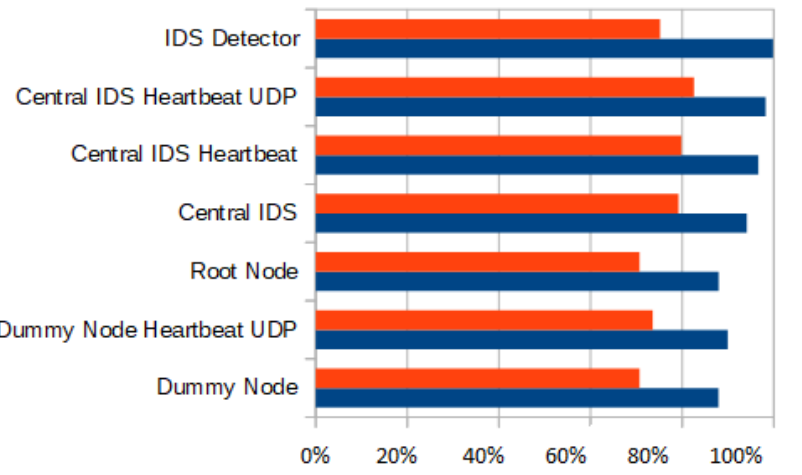
Figure 12. Comparison between node types in terms of RAM and ROM usage.